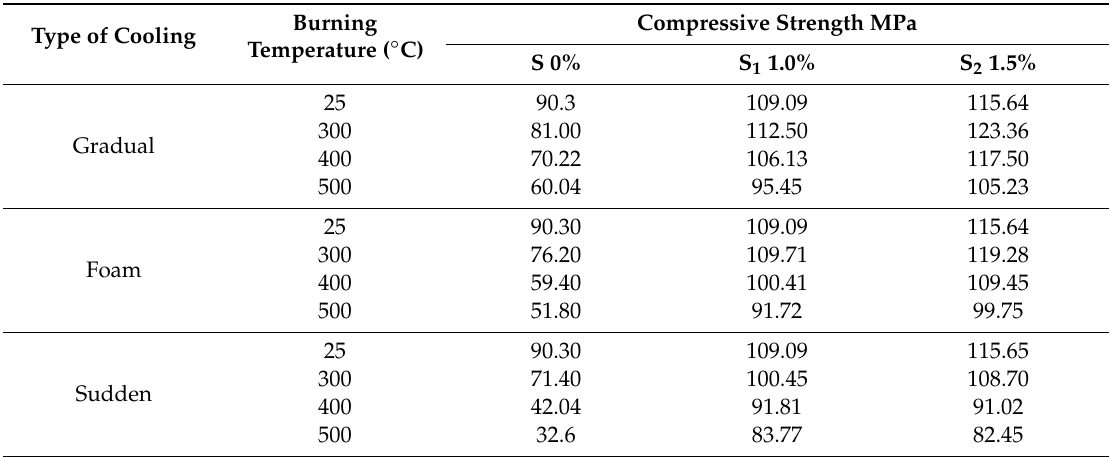
Table 6. Compressive strength results concerning all types of cooling for the adopted (RPC) mixes.